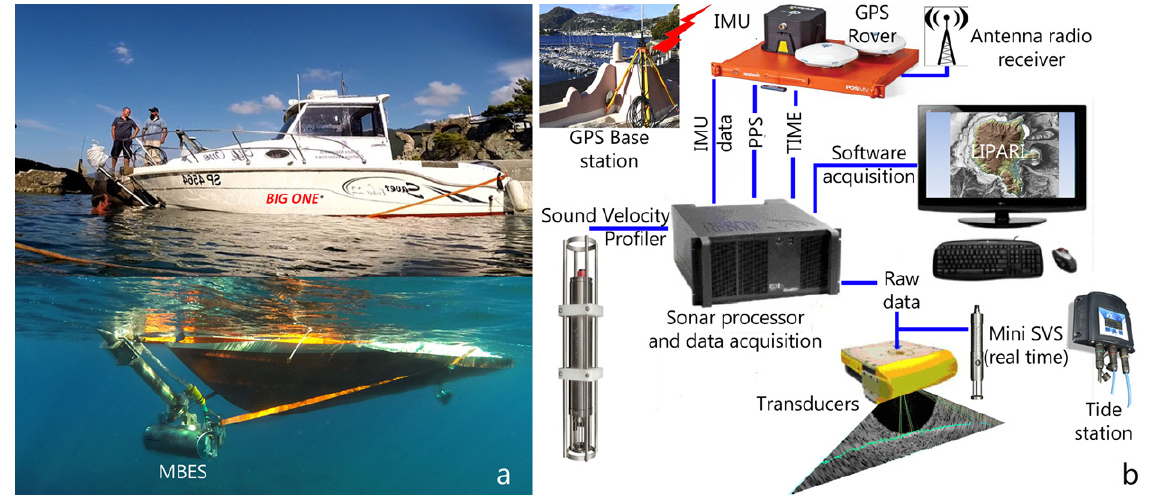
Figure 2. (a) The vessel “Big One” of the INGV equipped with the multibeam echo-sounder system; (b) multibeam system architecture of CNR-IGAG used during the ultra-high resolution bathymetric survey aroundLipari Island.